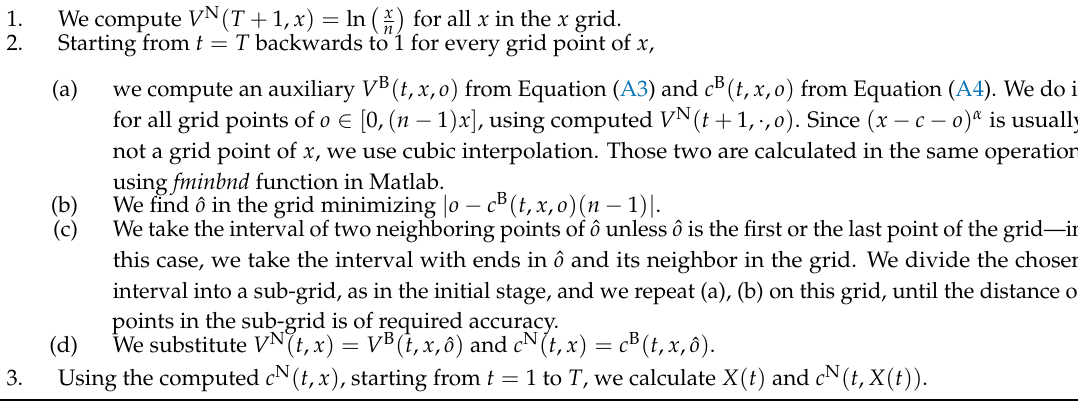
Algorithm A2. Computation of the Nash